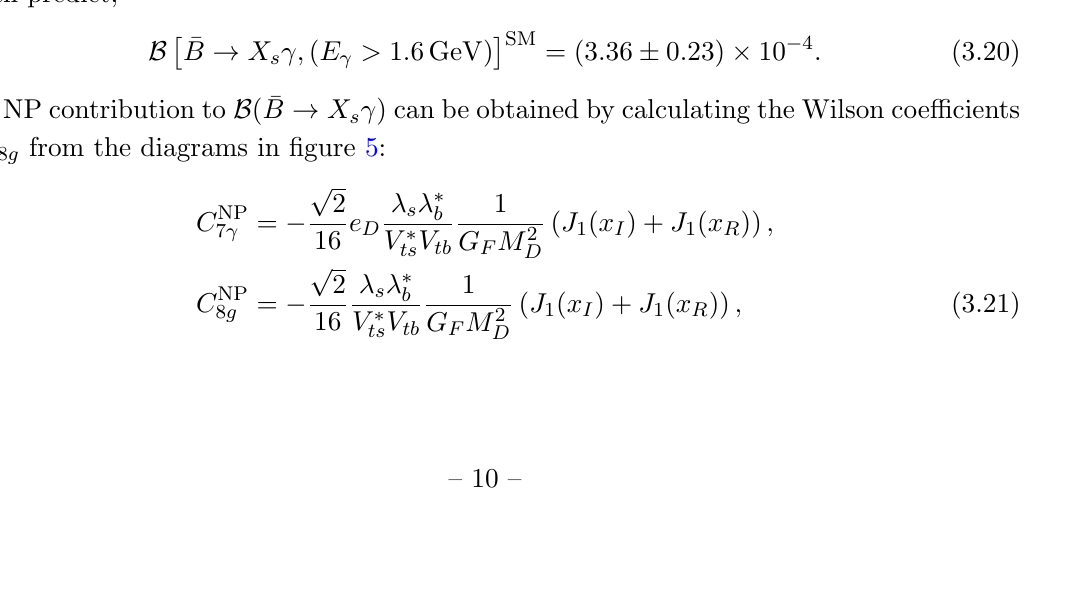
Figure 5 . Feynman diagrams for the new physics contributions to b line can be attached to any charged (colored)